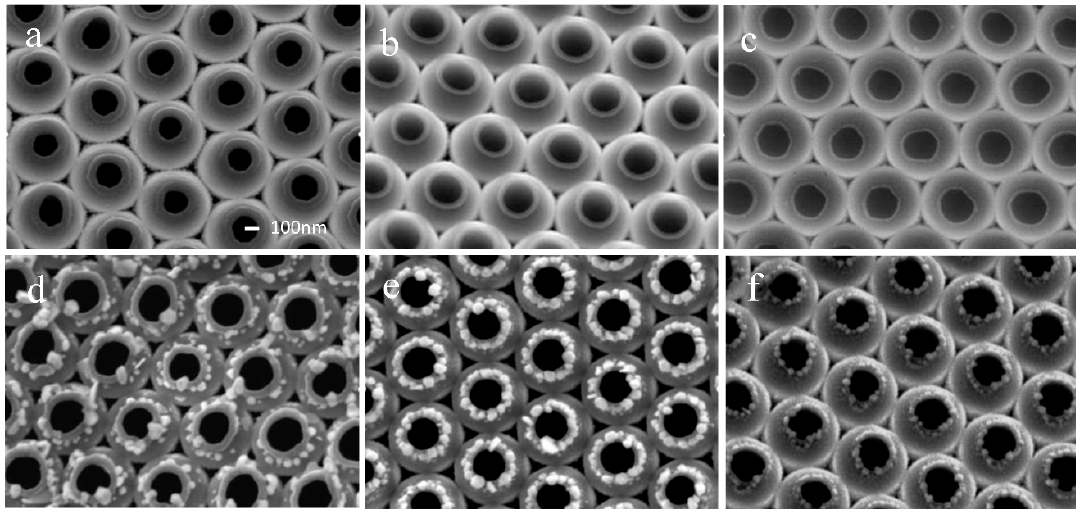
Figure 2. The structure of the nanojars changed with etching by plasma cleaner: ( a ) 0 s, ( b ) 30 s, ( c ) 45 s. The etching process changed the locations of silver growth ( d – f ). The scale bar in ( a ) represents a distance of 100 nm and is the same for all images.